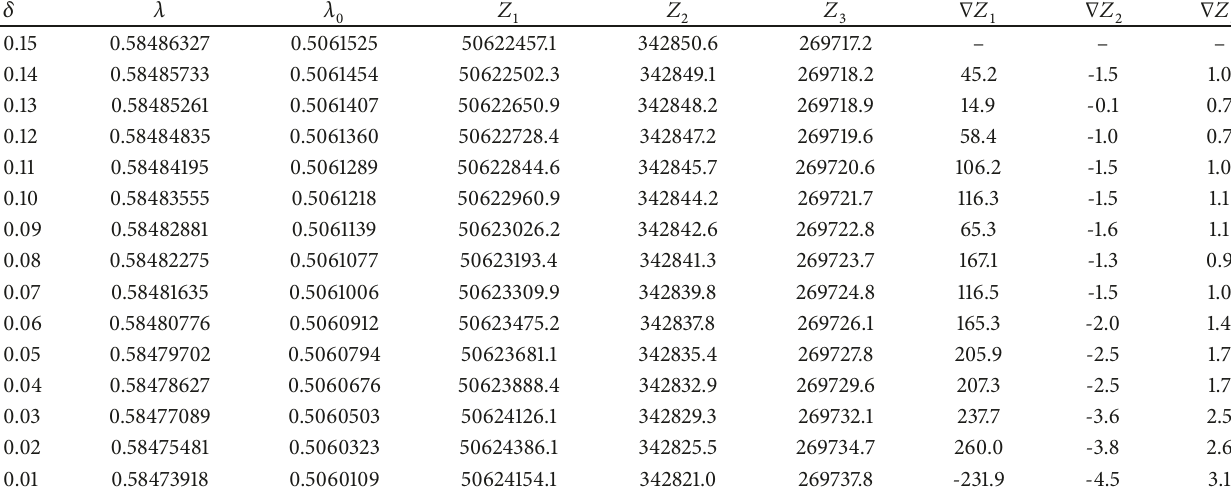
Table 13: Optimal solutions of different violation degree ( 𝛾 = 0.5